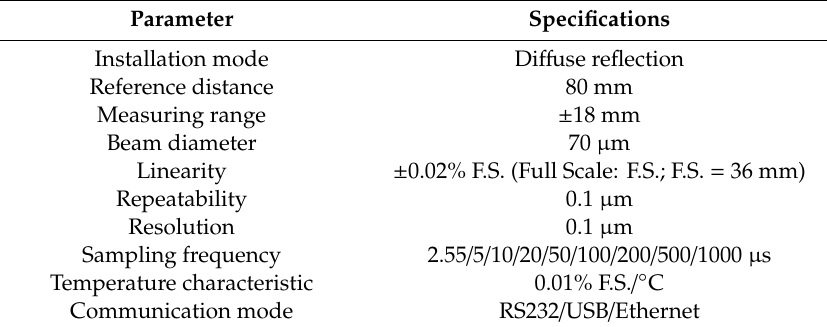
Figure 5. ( a ) Overview of the evaluation system; ( b ) an inclined evaluation model. Table 1. The main configuration parameters of the KEYENCE LK-H080